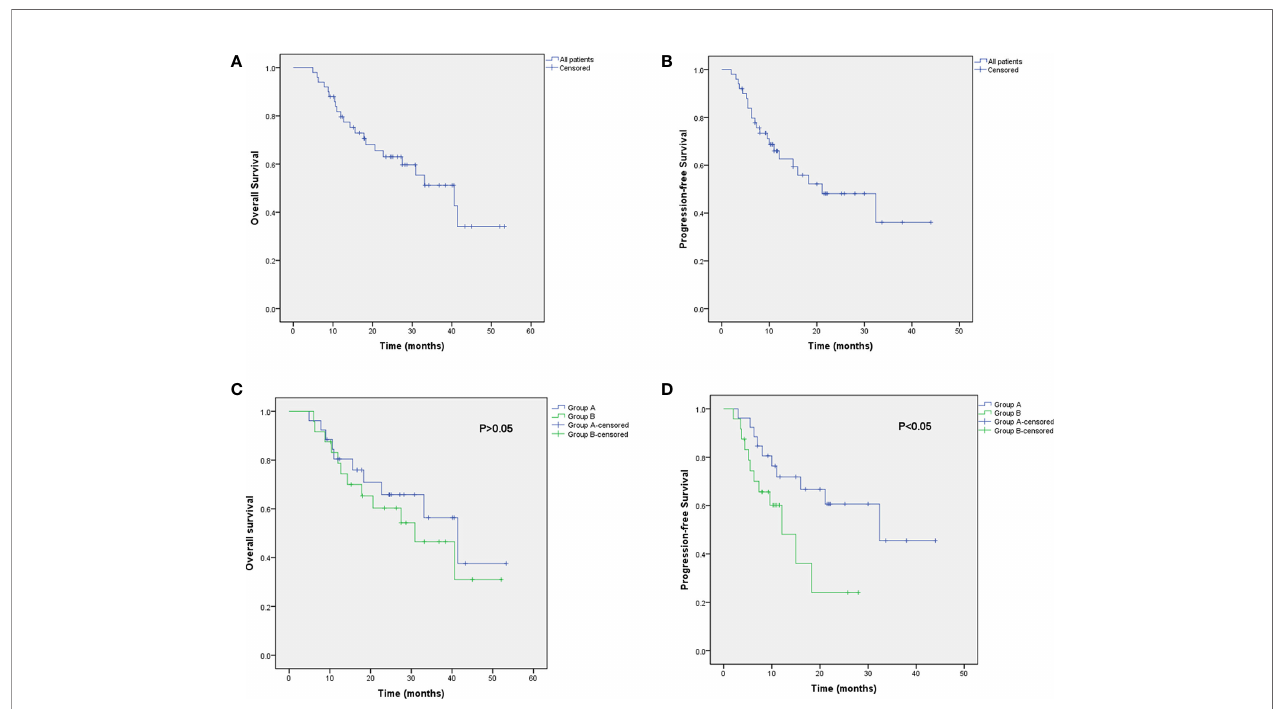
FIGURE 2 | Kaplan – Meier curve of OS (A) and PFS (B) for all patients. Kaplan – Meier curve of progression-free survival for all patients. Kaplan – Meier analysis of OS (C) and PFS (D) in group A and group